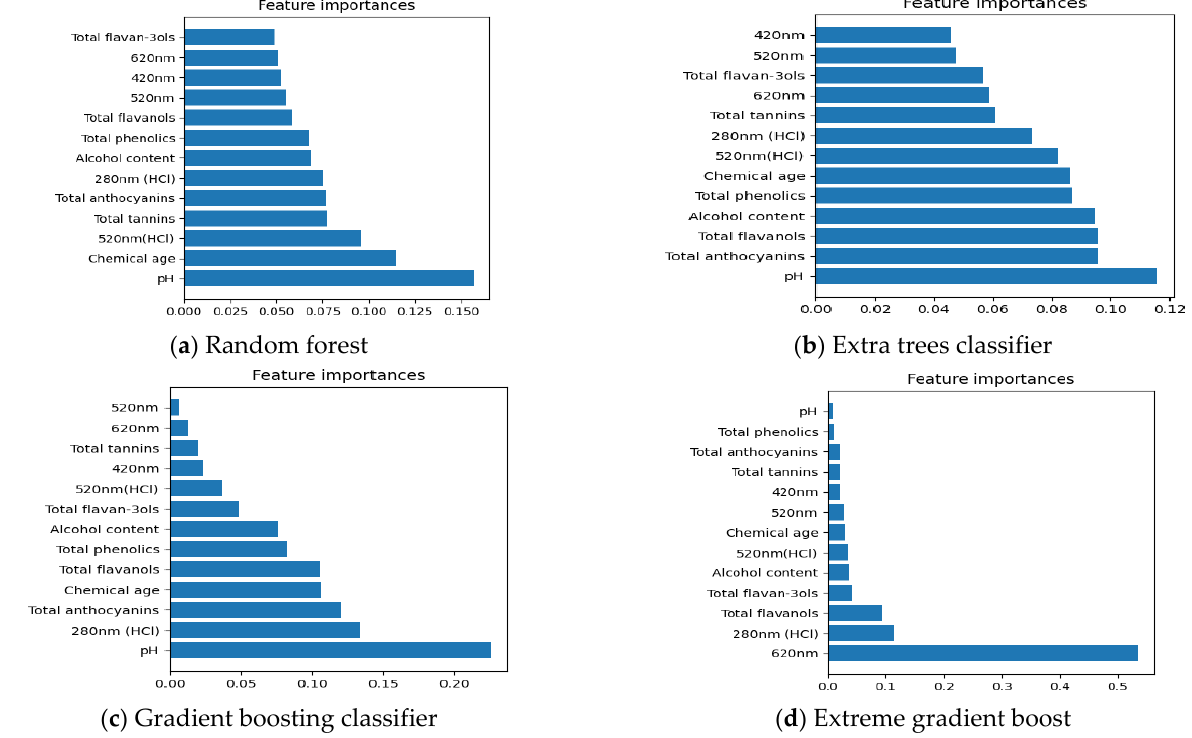
Figure 6. Features selection of 13 chemical data using Random forest, Extra trees classifier, gradient boosting classifier, and Extreme gradient boost in price points. ( a – d ) display the important chemical parameters in PricePoints are selected by Random Forest, Extra trees classifier, Gradient boosting classifier and Extreme gradient boost, respectively.